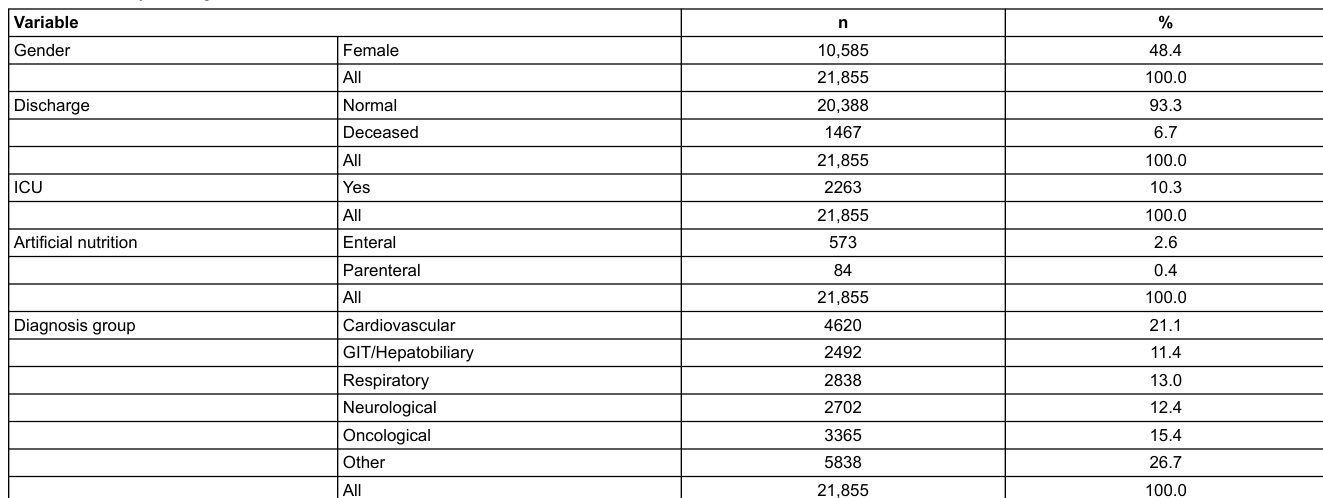
Table 2: Summary of categorical variables. Variable